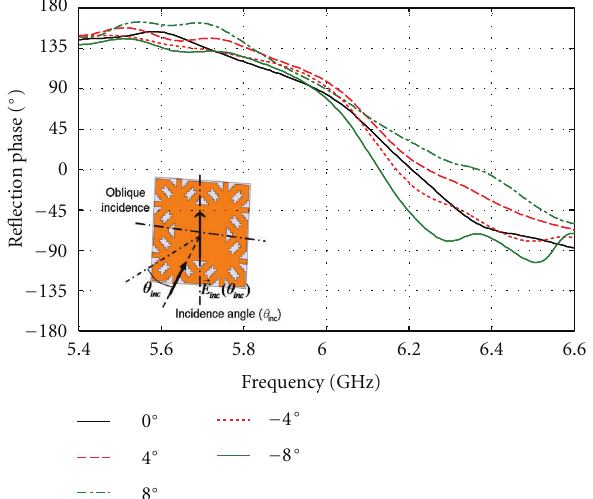
Figure 10: Reflection phase of the manufactured creeping proto- type for di ff erent incident angles ( θ inc